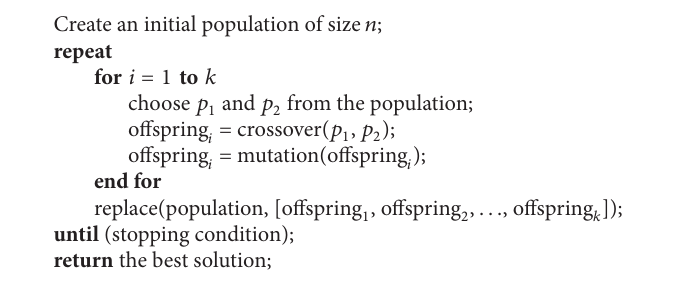
Pseudocode 2: The pseudocode of a genetic